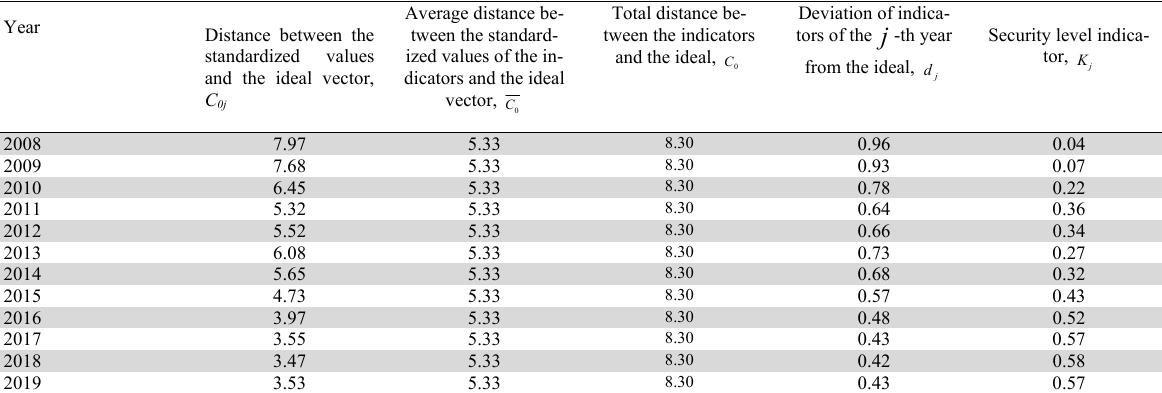
Considering the value of the ideal vector, additional indicators were calculated: the distance between observations and the ideal vector, the average and total distance of deviations from the ideal (Table 2). The obtained distance serves as the basis for calculating the indicator of the information security level of Ukraine. Table 2 The results of the calculation of the taxonomic indicator of the level of Ukraine’s economic security Deviation of indica- Average distance be- Total distance be- Year Distance between the tors of the j -th year tween the standard- tween the indicators ized values of the in- standardized values and the ideal, from the ideal, 0 C dicators and the ideal and the ideal vector, j vector, C 0j 0 С